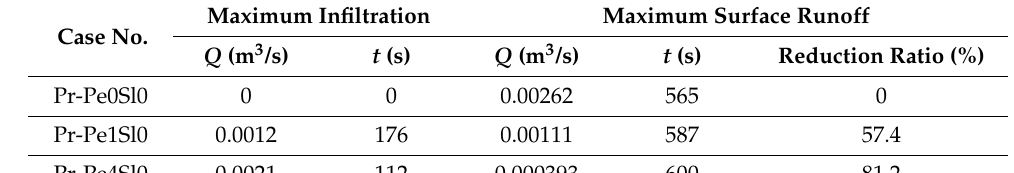
Table 7. Results of structure variation.